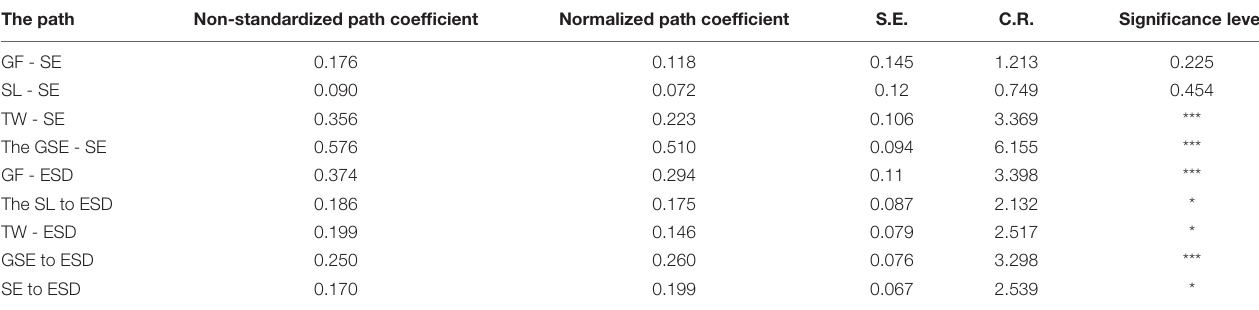
TABLE 4 | Path analysis and hypothesis testing